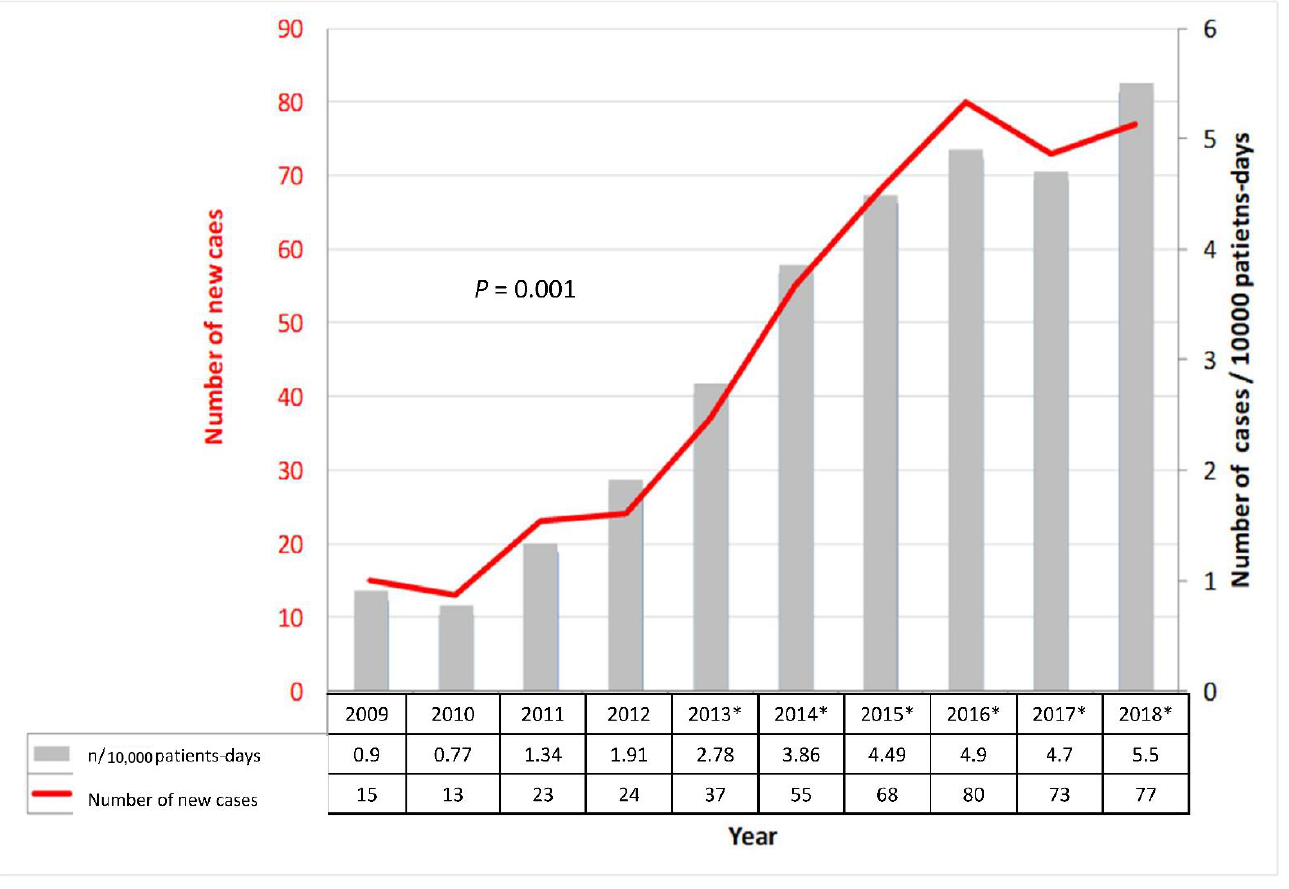
Table 1. Demographics, risk factors and clinical characteristics of patients included in the study (N = 443 cases).